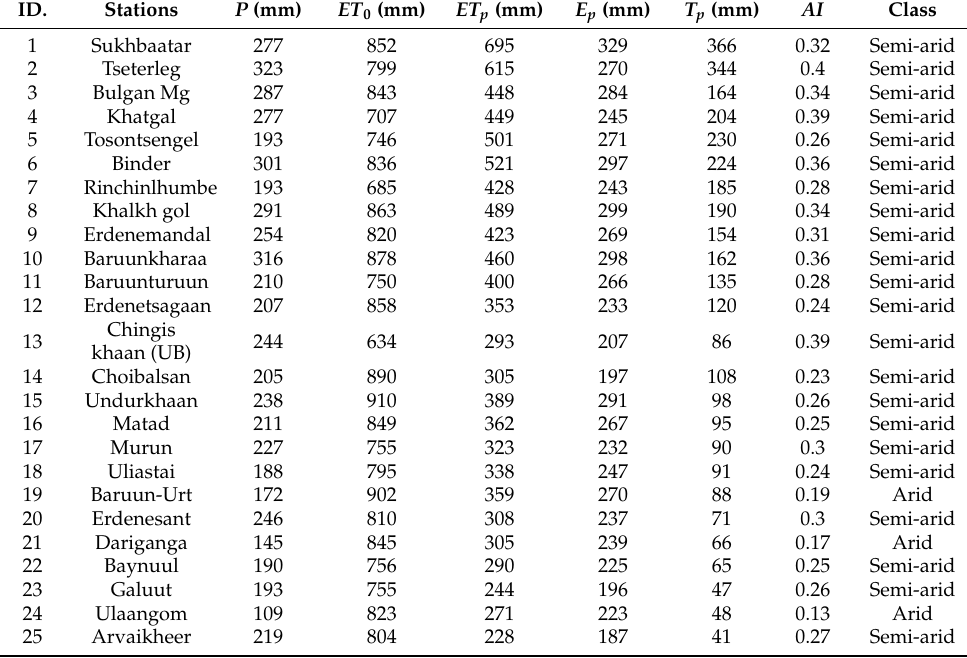
Table A3. Mean annual sums of water fluxes over 41 weather stations in Mongolia.